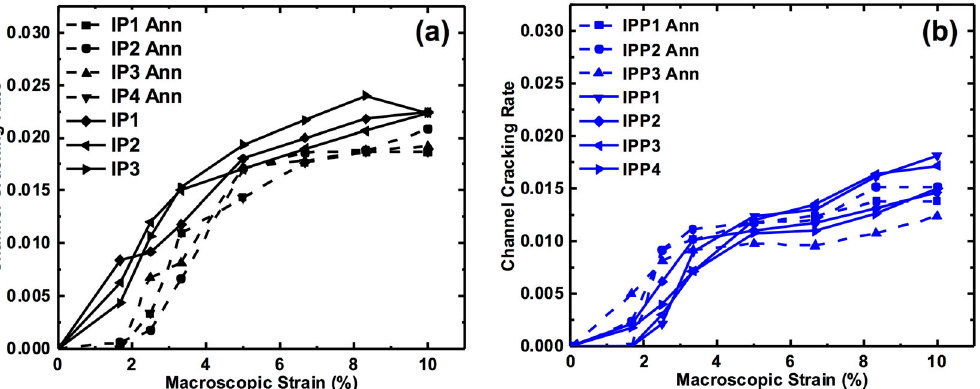
Fig. 7 Change in channel cracking rate with respect to the average macroscopic strain, for various sets of fi lms (( a ) IP and ( b ) IPP), as-deposited and annealed samples